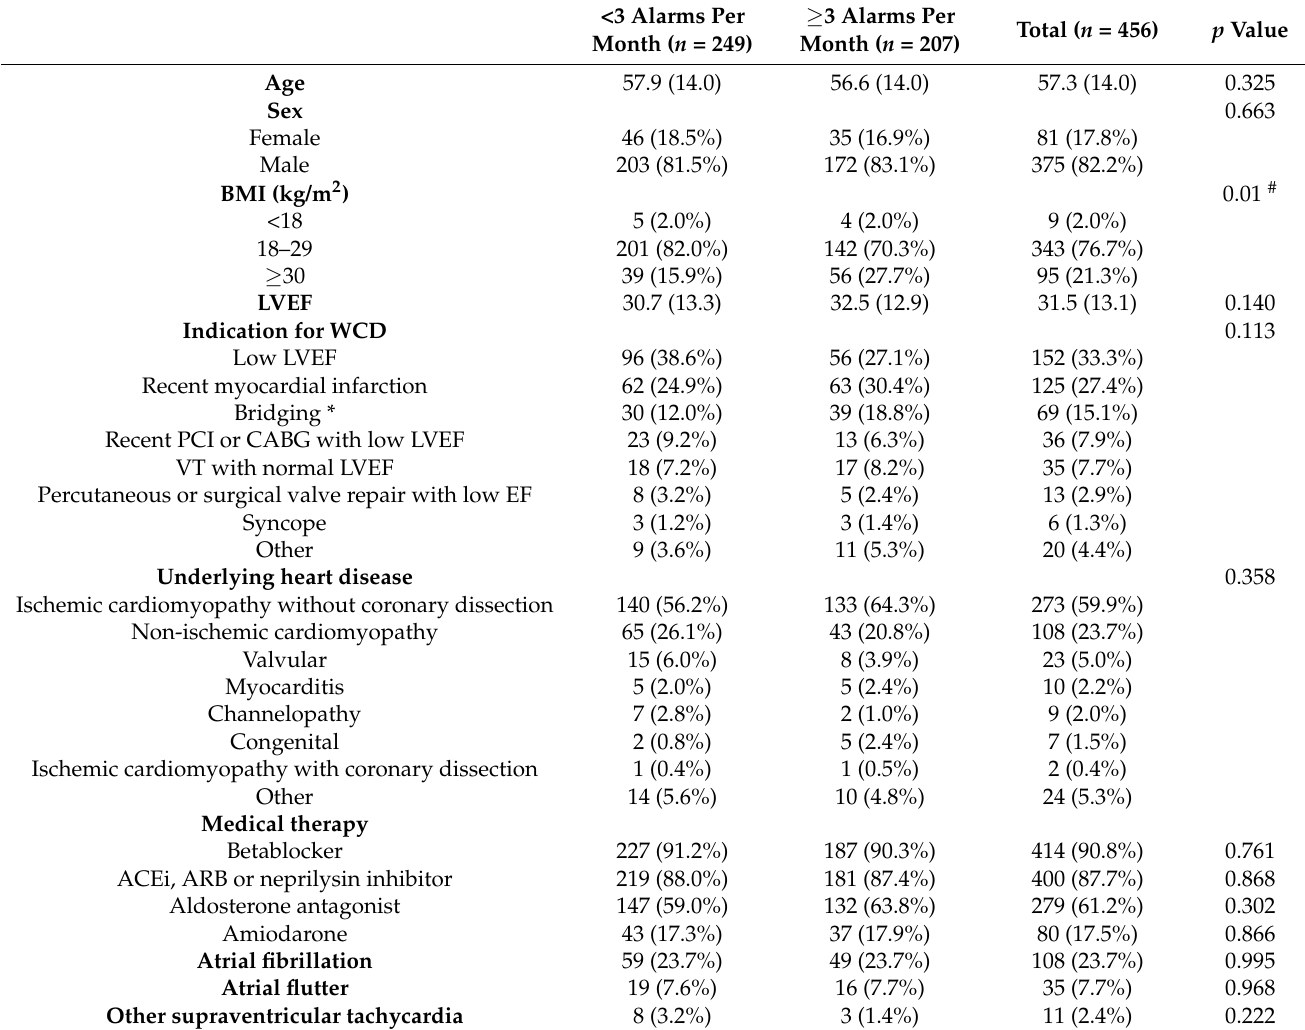
Table 1. Baseline characteristics of patients in the Swiss WCD